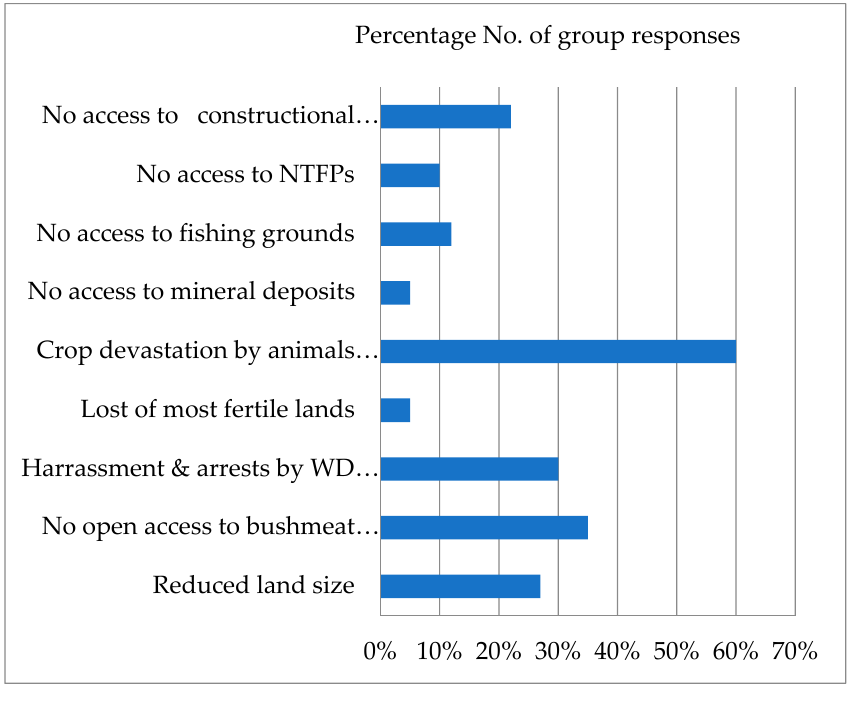
Figure 5. Problems imposed by a PA Establishment. Source: Fieldwork, (2016).